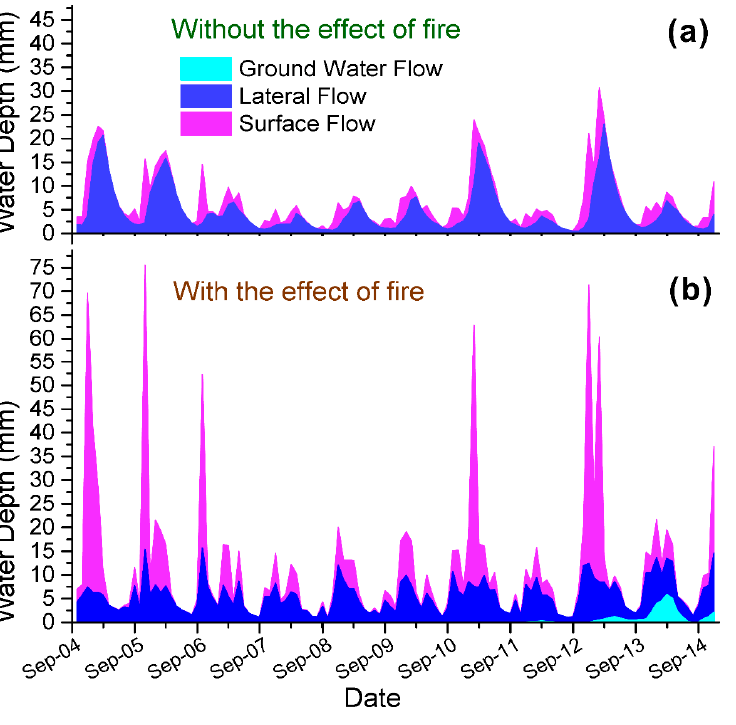
Figure 8. Temporal variation of the main components of the runoff response of the watershed for ( a ) the pre-fire and ( b ) the post-fire conditions.